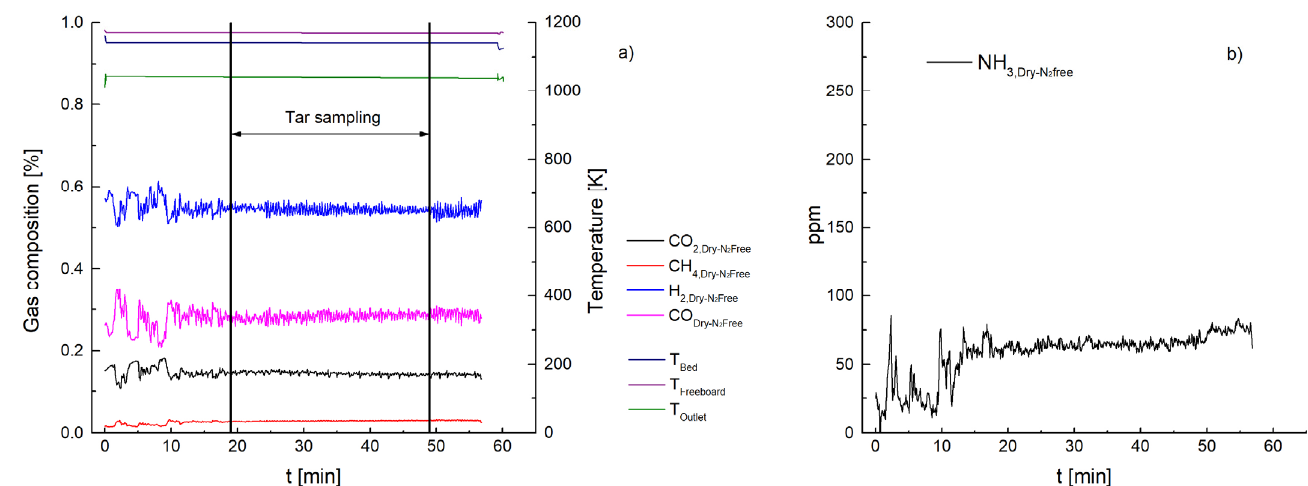
Figure A2. Temperature and gas composition ( a ) and ammonia content ( b ) during test 2.